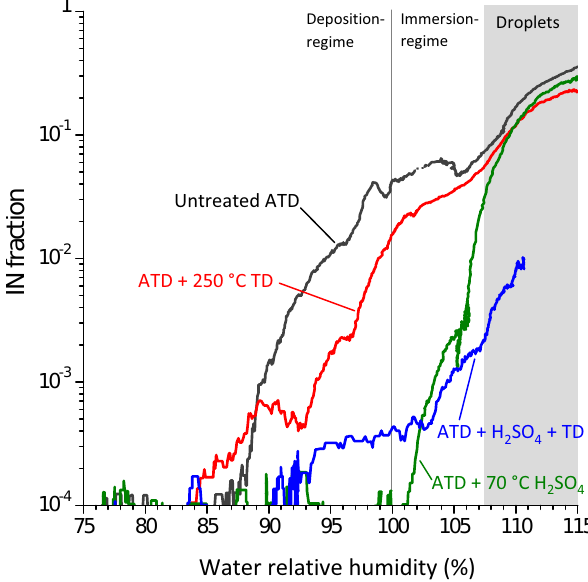
Fig. 2. Fraction of 300nm ATD particles that nucleated ice at − 30 ◦ C as the relative humidity with respect to water was increased. Data points collected at 1Hz during slow RH w scans and smoothed using a 30s adjacent average. Results for untreated ATD are dis- played along with those for ATD heated in the thermodenuder (TD) at 250 ◦ C, ATD coated with sulphuric acid (SA) at 70 ◦ C, and coated ATD subsequently heated in the TD before analysis in the CFDC. Above ∼ 107% RH w droplets broke through the evaporation region and could not be distinguished from ice crystals (grey